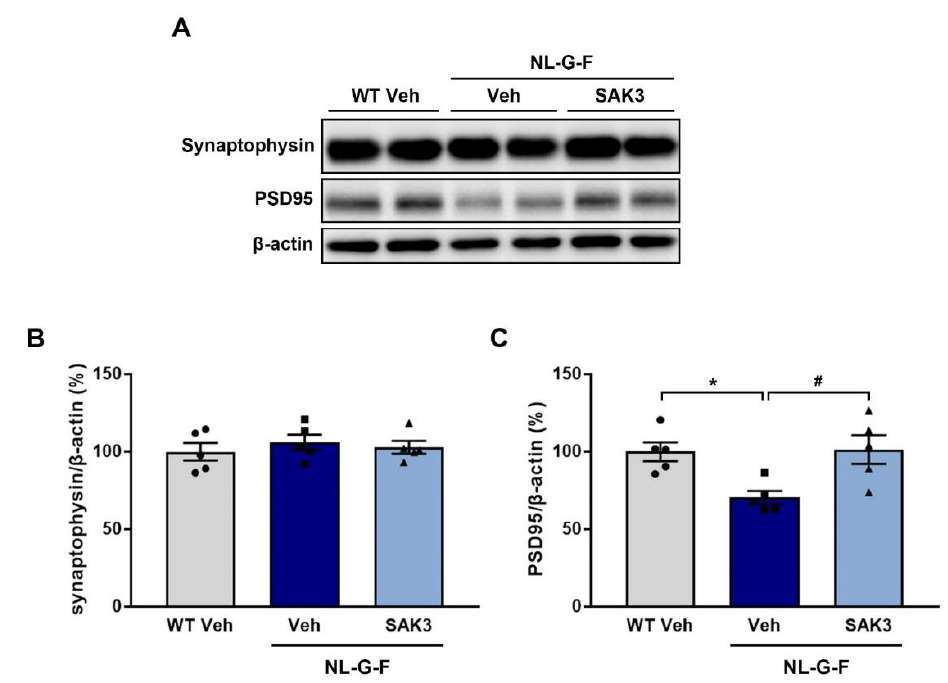
Figure 5. SAK3 administration rescues the reduction in PSD95 expression in NL-G-F mice. ( A ) Representative image of western blot membranes containing hippocampal protein probed with antibodies against synaptophysin, PSD95, and β -actin. Quantitative analyses of ( B ) synaptophysin and ( C ) PSD95 protein levels ( n = 5 per group). F (2, 12) = 6.52, p < 0.05. Error bars represent SEM. * p < 0.05 vs. vehicle-treated WT mice; # p < 0.05 vs. vehicle-treated NL-G-F mice. The symbols (solid dots, squares and triangles) indicate the individual values.